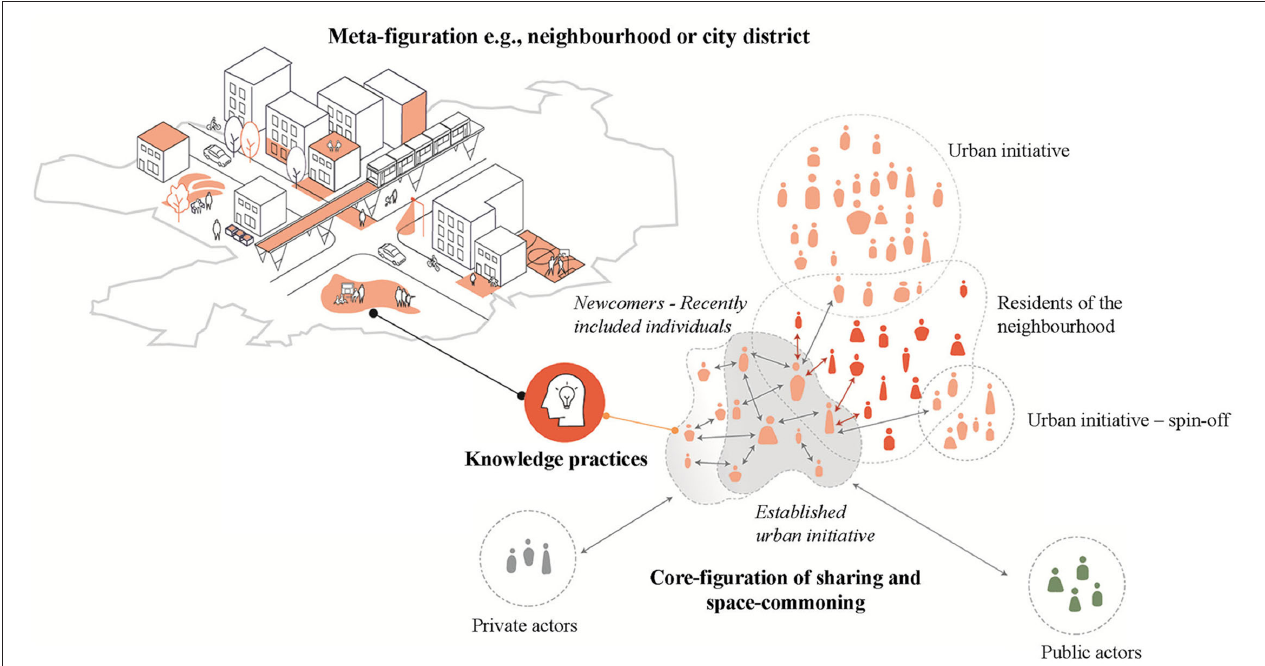
FIGURE 1 | Knowledge practices in figurationsof sharing and space-commoning. Helena Cermeño, adjusted from the original by Sina Doukas (StadtTeilen) and inspired by Etzold et al.